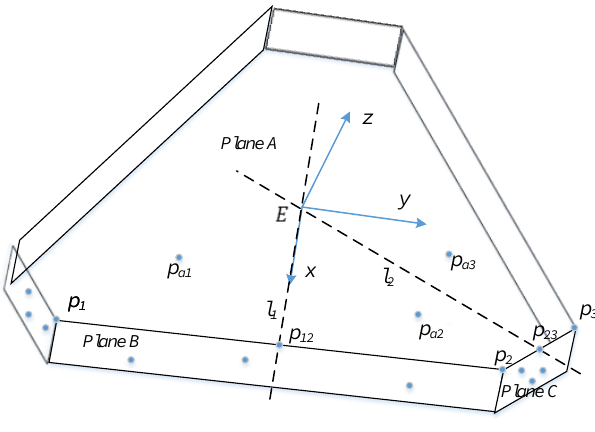
Figure 10. Measurement of Σ E .